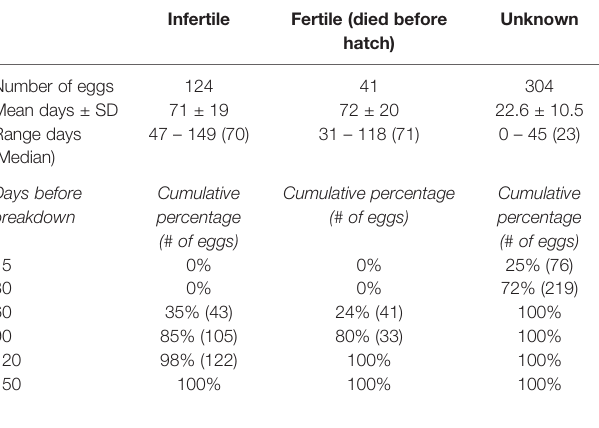
TABLE 2 | Days until yolk deterioration for eggs categorized as Infertile, Fertile and Unknown fertility